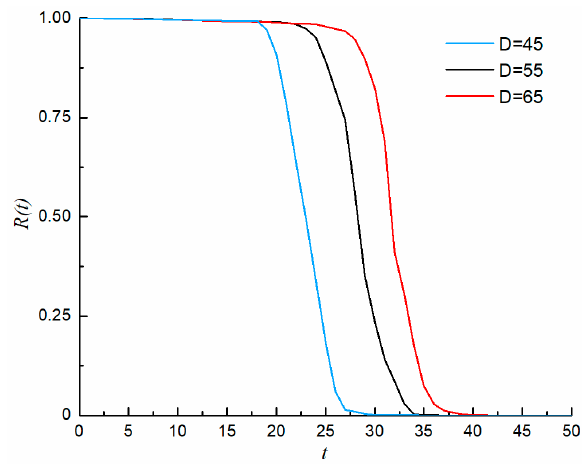
Figure 3. Reliability curves with varying soft-failure threshold.